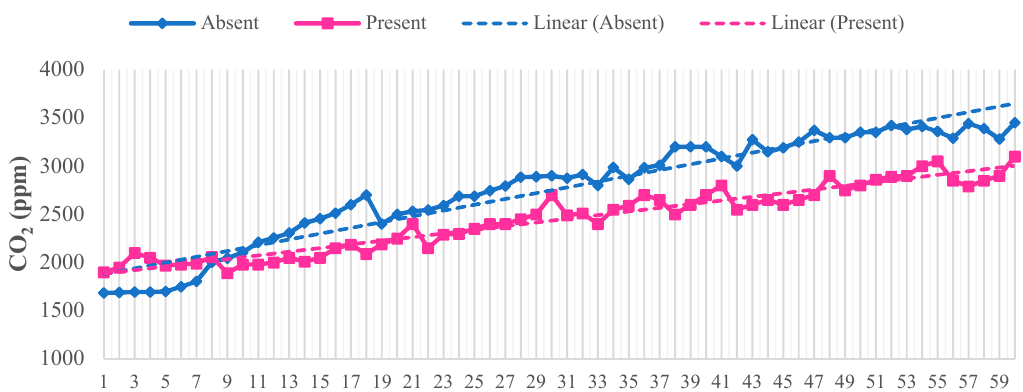
Figure 4. Changes in CO 2 with or without plants.